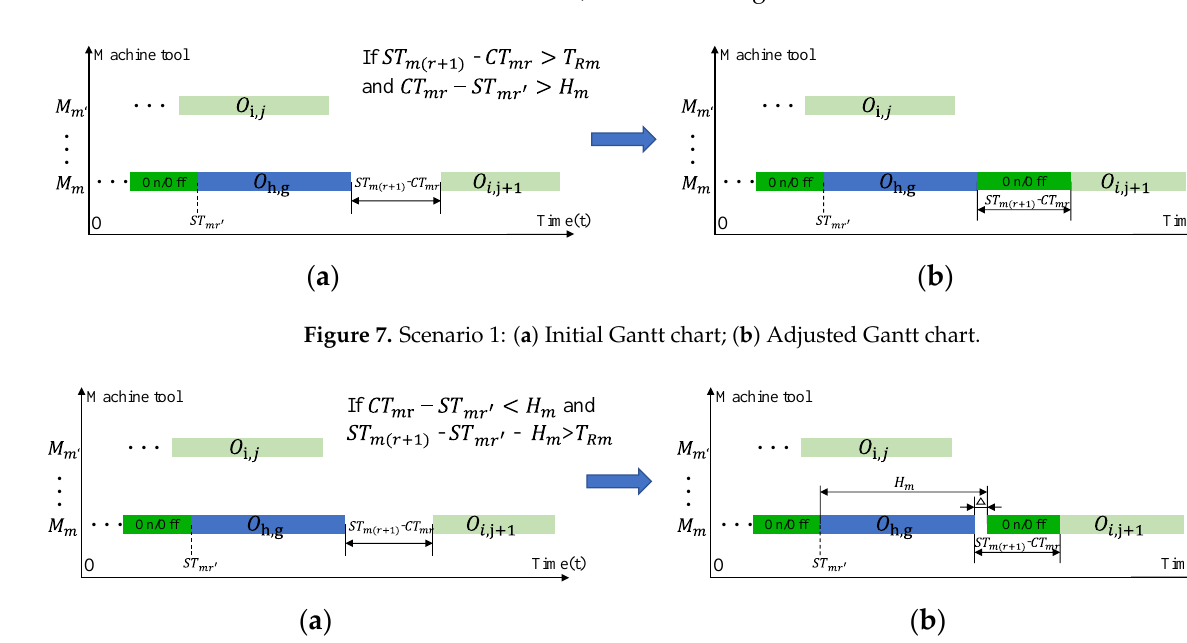
Figure 8. Scenario 2: ( a ) Initial Gantt chart; ( b ) Adjusted Gantt chart.